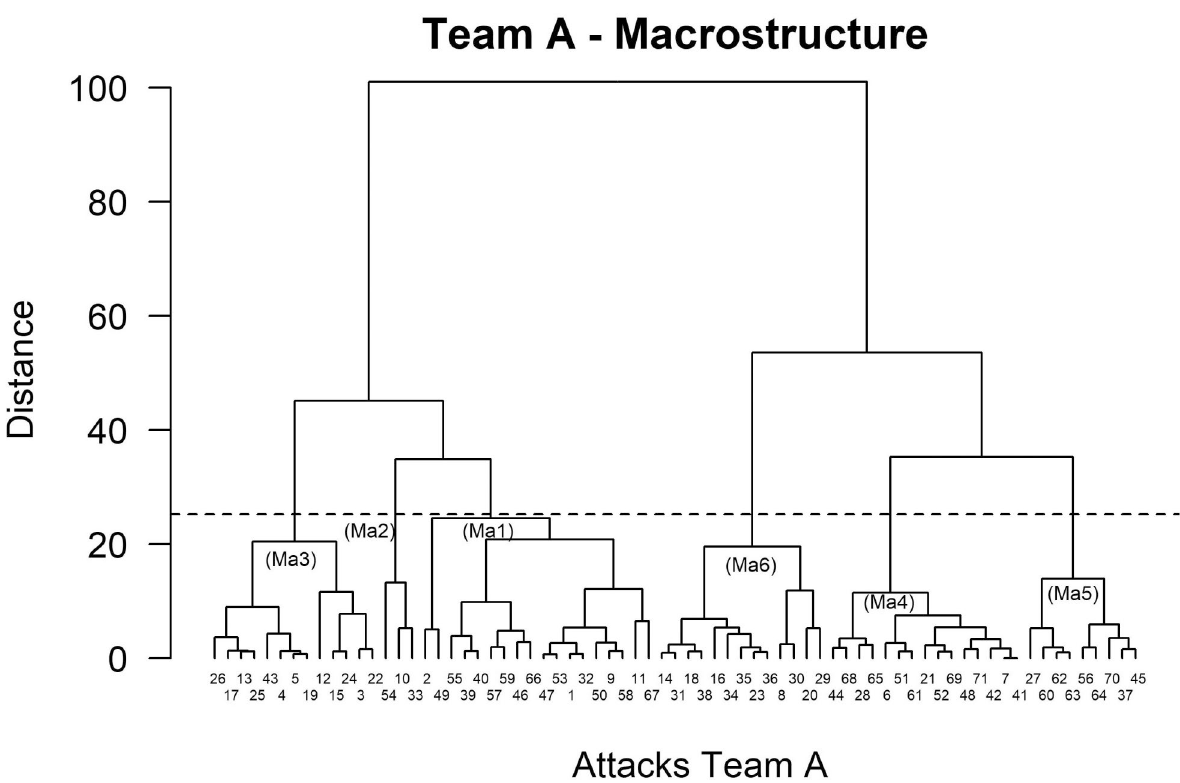
Figure 3 - Dendrogram representing six macrostructure patterns of team A (Ma1, Ma2, Ma3, Ma4, Ma5 e Ma6) throughout 71 attack sequences in